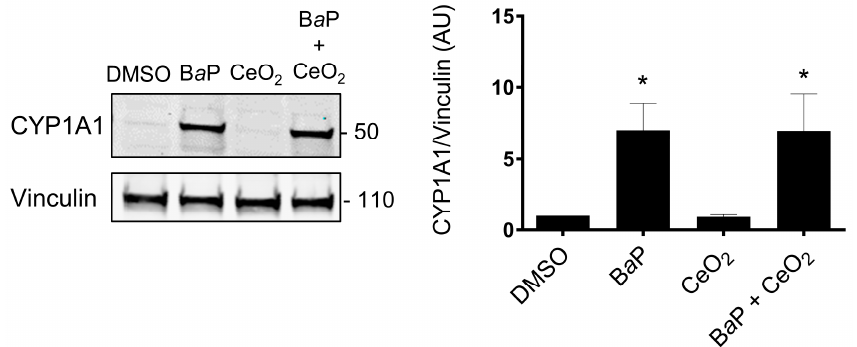
Figure 3. Homogeneity of the cellular response to benzo(a)pyrene and cerium dioxide nanoparticles in independent VCT cultures from 5 placentas. VCT purified from 5 different term placentas were plated overnight in culture and then were incubated either with DMSO or with B a P (0.6 µM) or CeO 2 NP (6.3 µg/cm 2 ), and in B a P and CeO 2 NP co-exposure for 24 h. Total protein extracts (30 µg) were subjected to SDS-PAGE under reducing conditions and membranes were immunoblotted with anti-CYP1A1 and anti-vinculin (loading control) antibodies. Immunoblots were quantified with an Odyssey System Imager and results in the bar scale graph represent the mean +/ − SEM after normalization to vinculin ( n = 5). * p < 0.05 vs. DMSO.